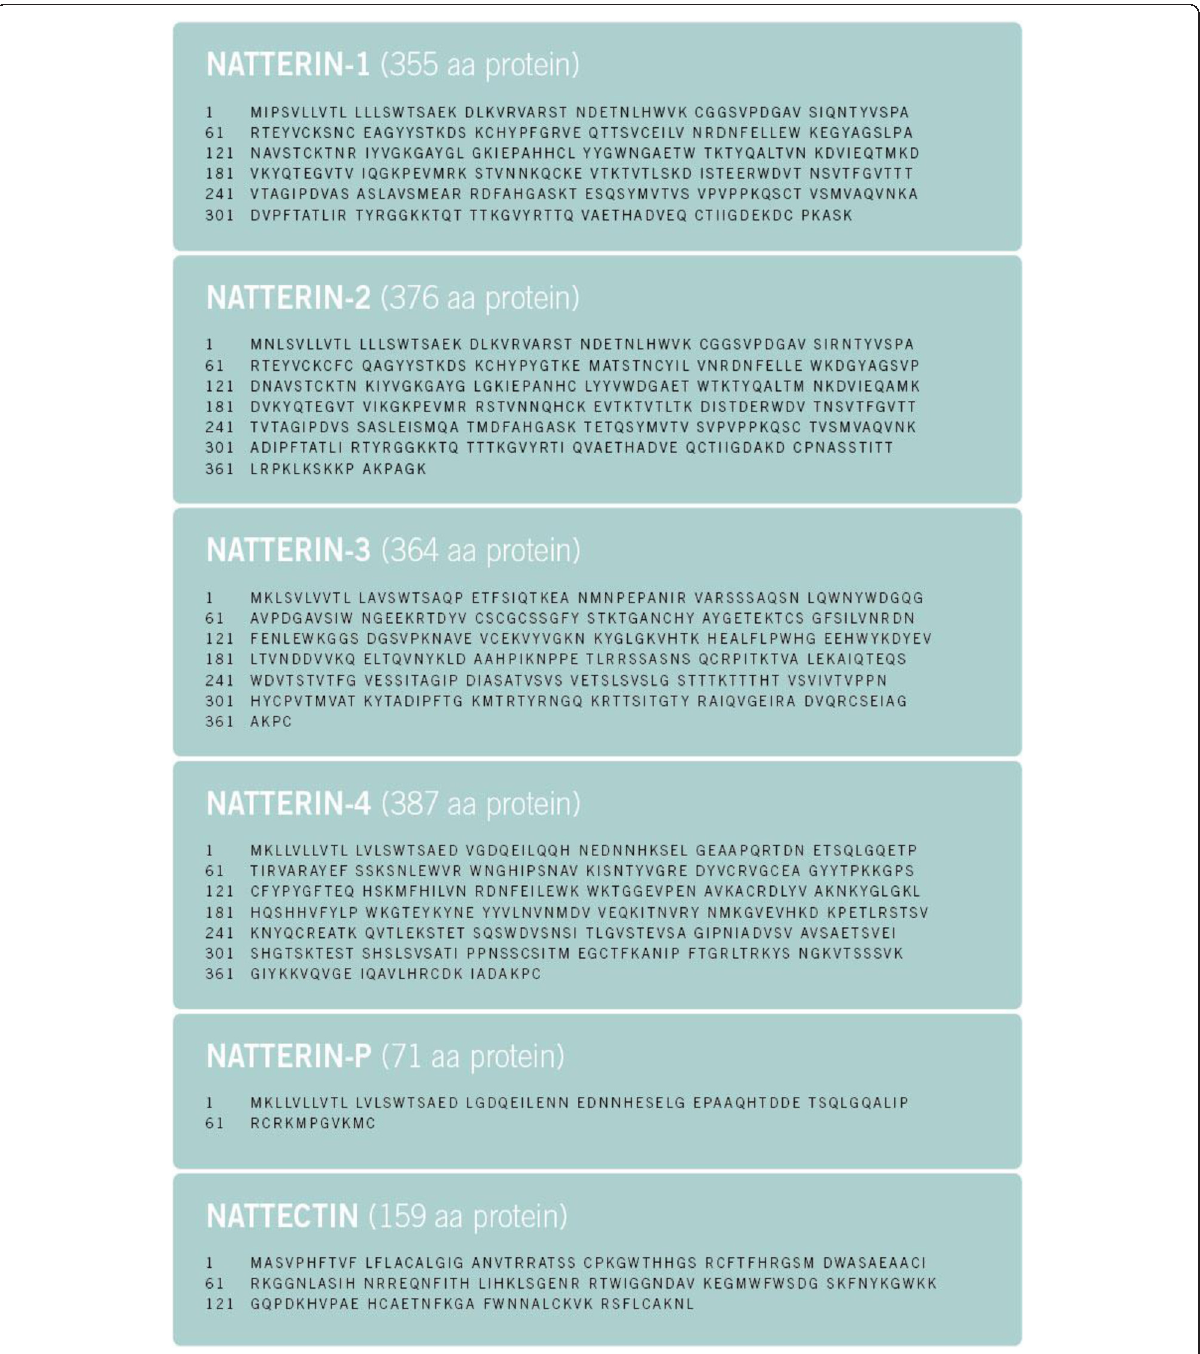
Figure 4 Primary structure of toxins was obtained by a transcriptomic approach using a representative cDNA library constructed from T. nattereri venom glands. This approach also allowed us to prove the existence of natterins (1 – 4 and P), a novel family of kininogenases, and a toxic C-type lectin